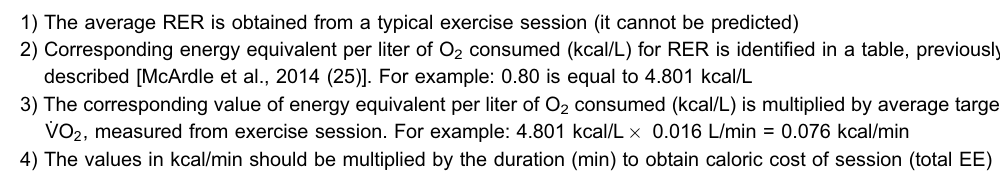
Table 2. Determination of caloric cost of exercise session from respiratory exchange ratio (RER)